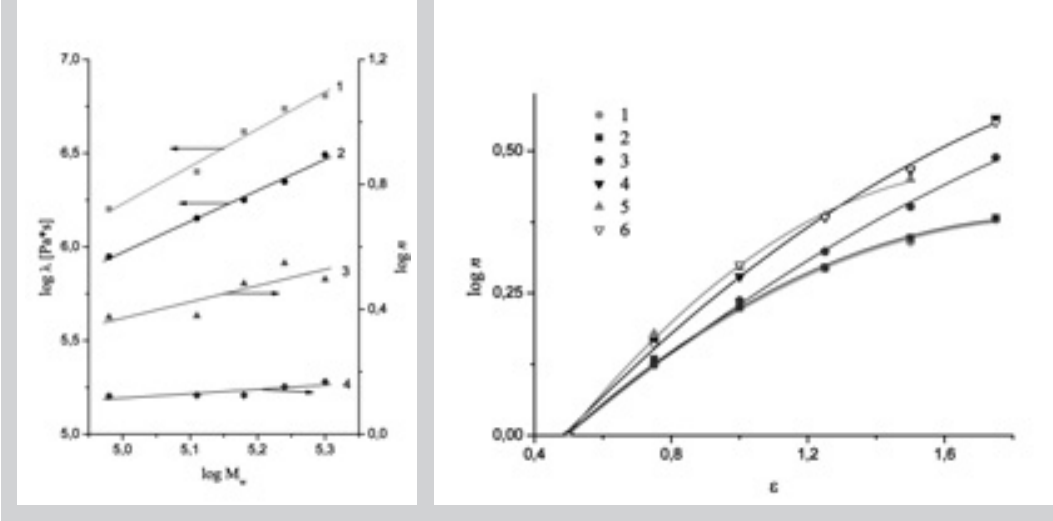
Figure 8 (left): Apparent elongational vis- cosity (1, 2) and the strain hardening index (3, 4) verus of SAN for the studied M w ABS samples at deforma- tions 0.75 (1, 3) and 1.75 (2, 4). Figure 9: Strain hardening index vs. deformation for ABS-1 (1), ABS-2 (2), ABS-3 (3), ABS-4 (4), ABS-6 (5) and the neat SAN (6) (T = 150°